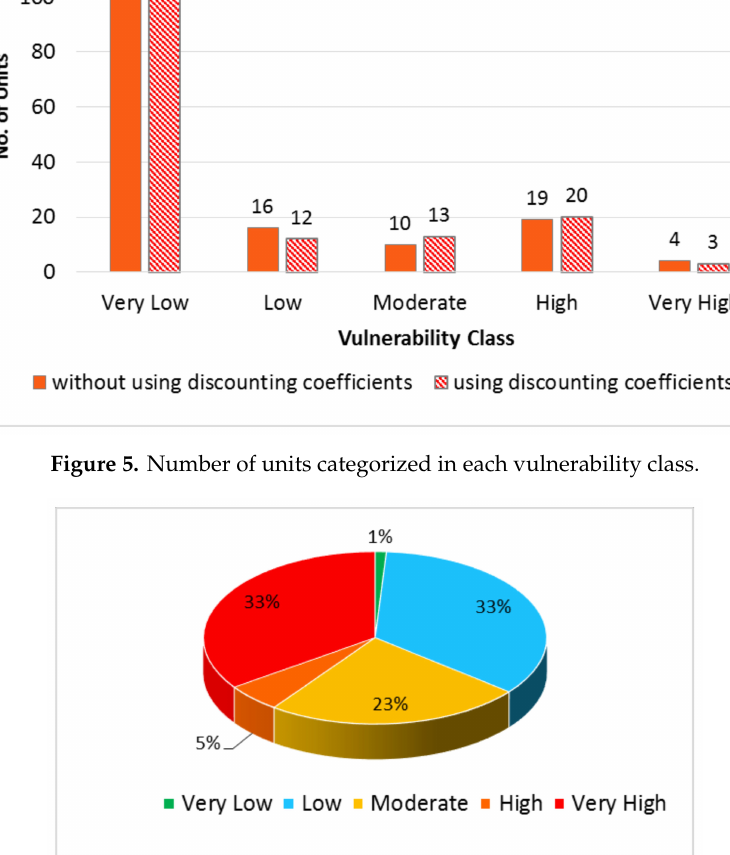
Figure 6. The changes occurred in classification of statistical units to vulnerability classes by removing the discounting coe ffi